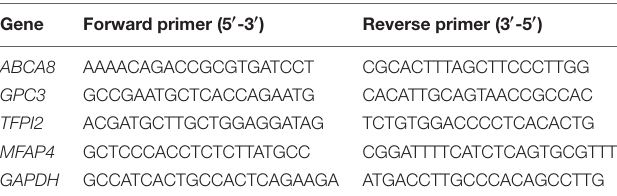
TABLE 2 | Primers used for